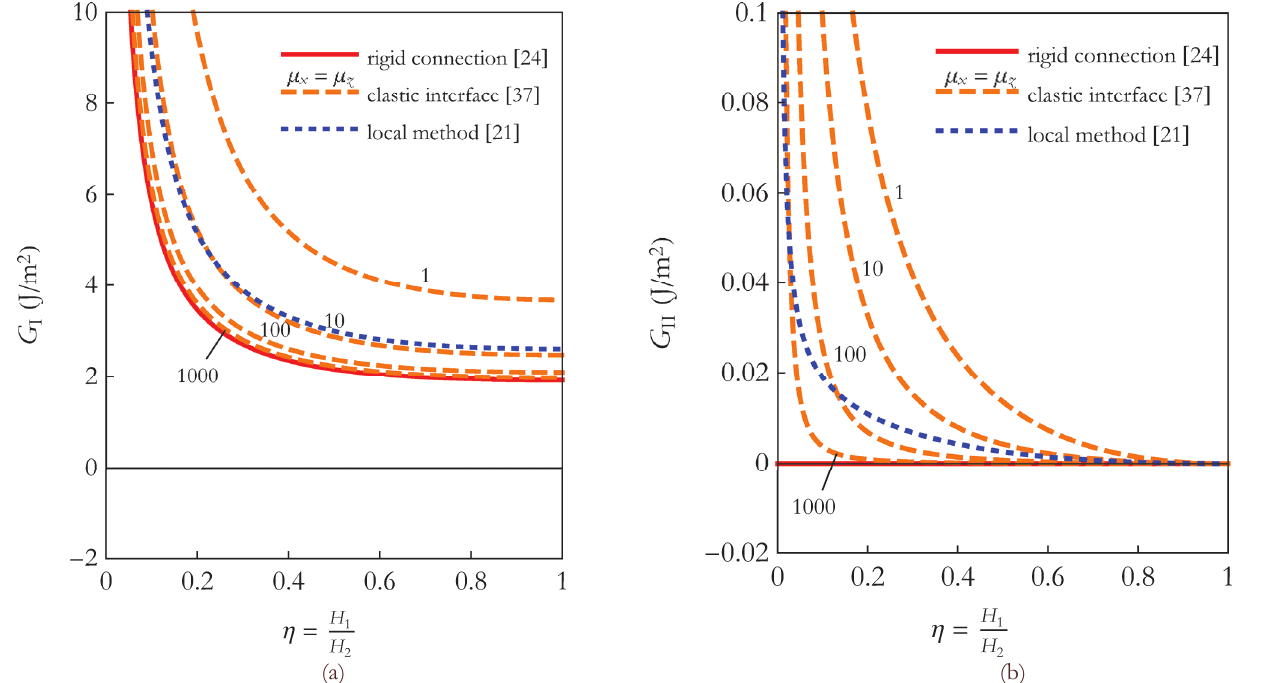
Figure 9: (a) Mode I and (b) mode II contributions to the energy release rate due to symmetric shear